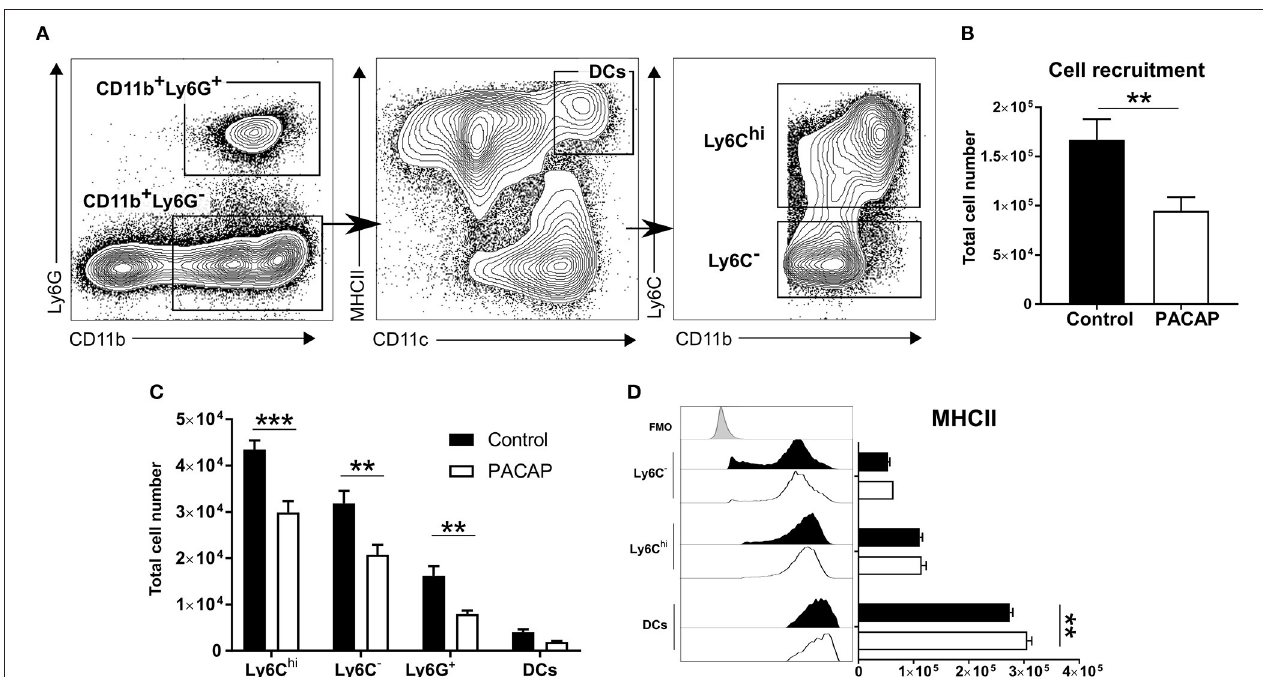
FIGURE 1 | Immune cell recruitment and activation upon PACAP administration. Peritoneal cells of acutely-infected mice were analyzed by flow cytometry. Cells were selected based on the forward-scatter/side-scatter plot (FSS/SSC) and living, single cells were chosen for further analysis (not shown). (A) Gating strategy used to discriminate CD11b + Ly6G + neutrophils and CD11b + Ly6G − monocyte-derived cells. CD11b + Ly6G − monocyte-derived cells were further divided into CD11c hi MHCII hi DCs and then differentiated according to Ly6C expression: Ly6C hi inflammatory monocytes and Ly6C − peritoneal macrophages. (B) Shows the total recruitment of living single cells. (C) Bar charts show cell recruitment of the identified cell populations in peritoneal cavity exudate of control and PACAP-treated groups (control: black bars; PACAP-treated: white bars). (D) Histograms and bar charts show expression of the activation marker MHCII on peritoneal cell subsets according to median fluorescence intensity (MFI). Control (black bars/histogram) and PACAP-treated (white bars/histogram); FMO (gray histogram) data are expressed as mean ± SEM, ** p < 0.01, *** p < 0.001 (two-tailed unpaired t